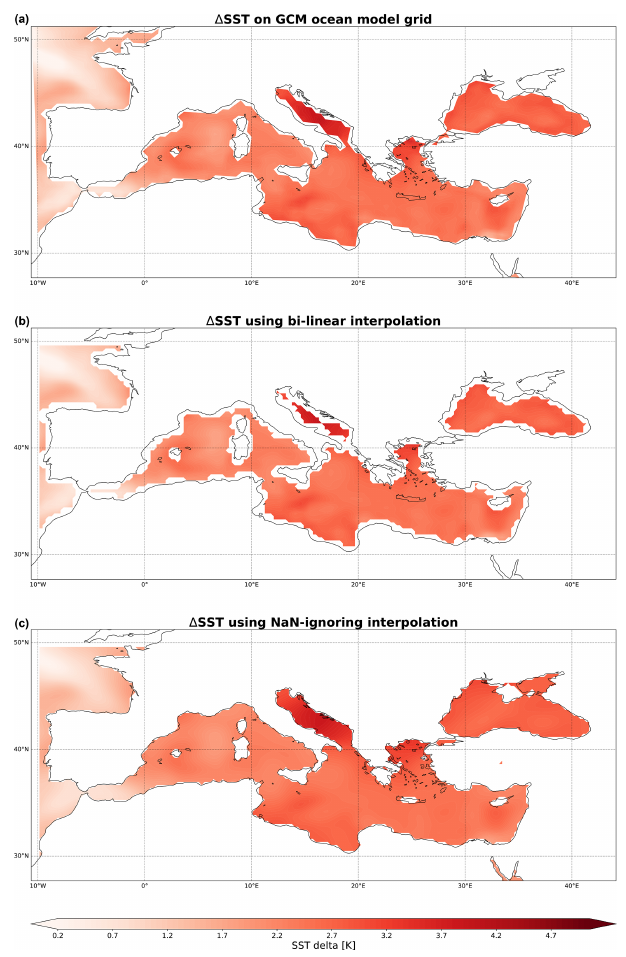
Figure 4. Monthly mean sea surface temperature climate delta ( (cid:49) SST) during January obtained from a GCM. (a) (cid:49) SST is shown on the native grid of the GCM ocean model. (b) (cid:49) SST after naive bilinear interpolation onto the reanalysis grid. Information is lost around the coastlines. (c) (cid:49) SST after NaN-ignoring interpolation onto the reanalysis grid. Hereby, additional detail near the reanalysis coastlines is achieved through extrapolation of the original (cid:49) SST. Further information about the data and interpolation used is given in Table